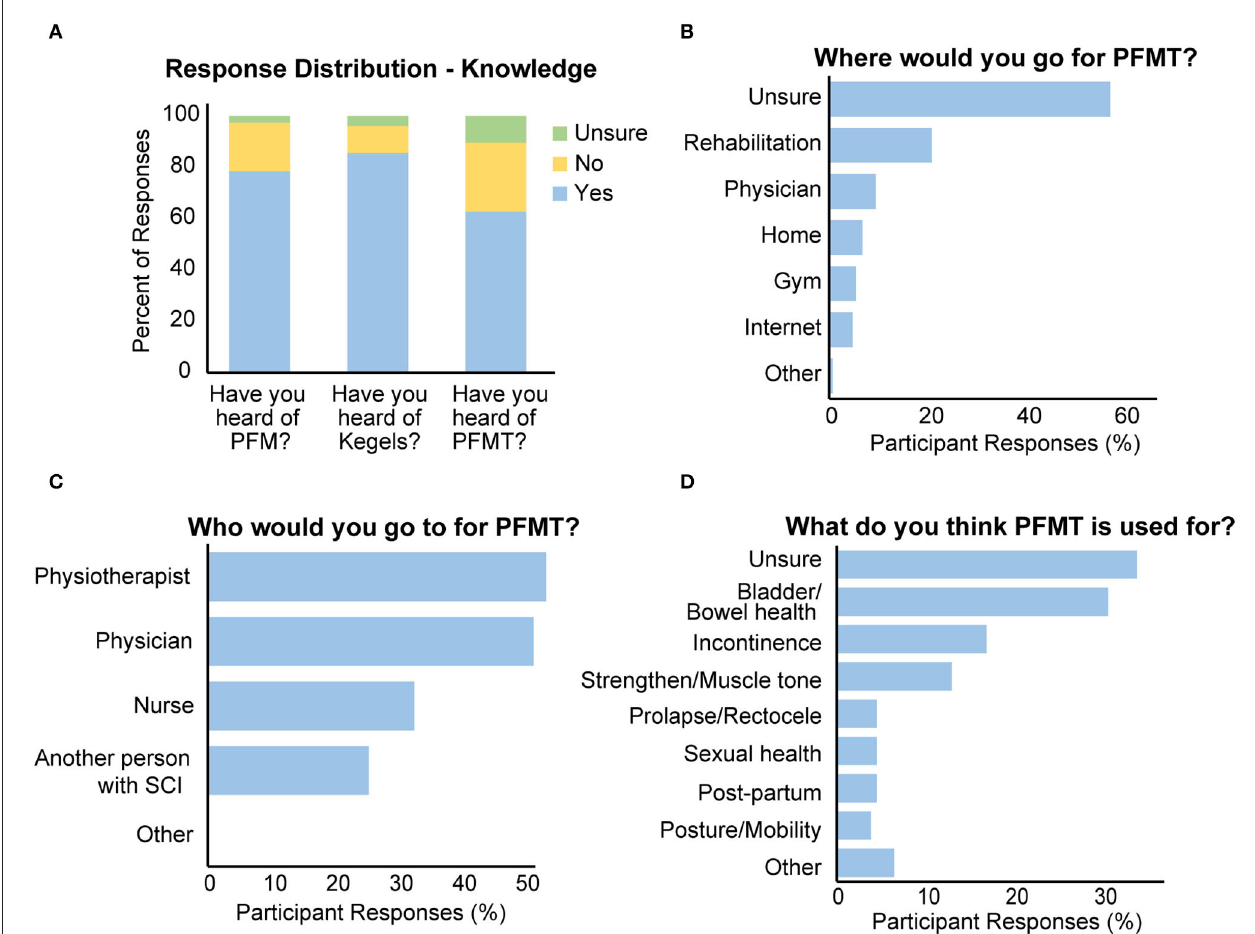
FIGURE 1 | Results from the knowledge portion of the questionnaire. (A–C) Responses from knowledge question prompts. The title of the chart indicates which question was asked. (D) Results from the knowledge portion of the questionnaire.